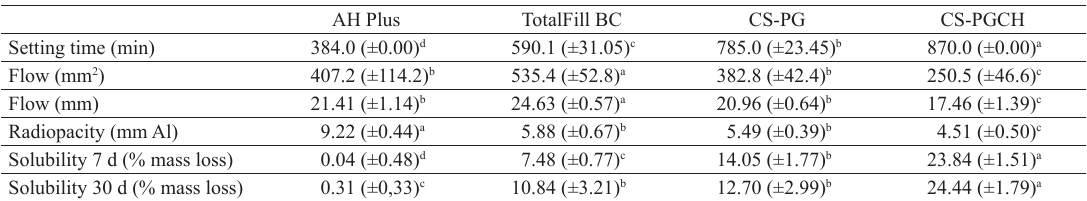
Table 2. Setting time, flow, radiopacity, and solubility (mean and standard deviation) observed in the different endodontic